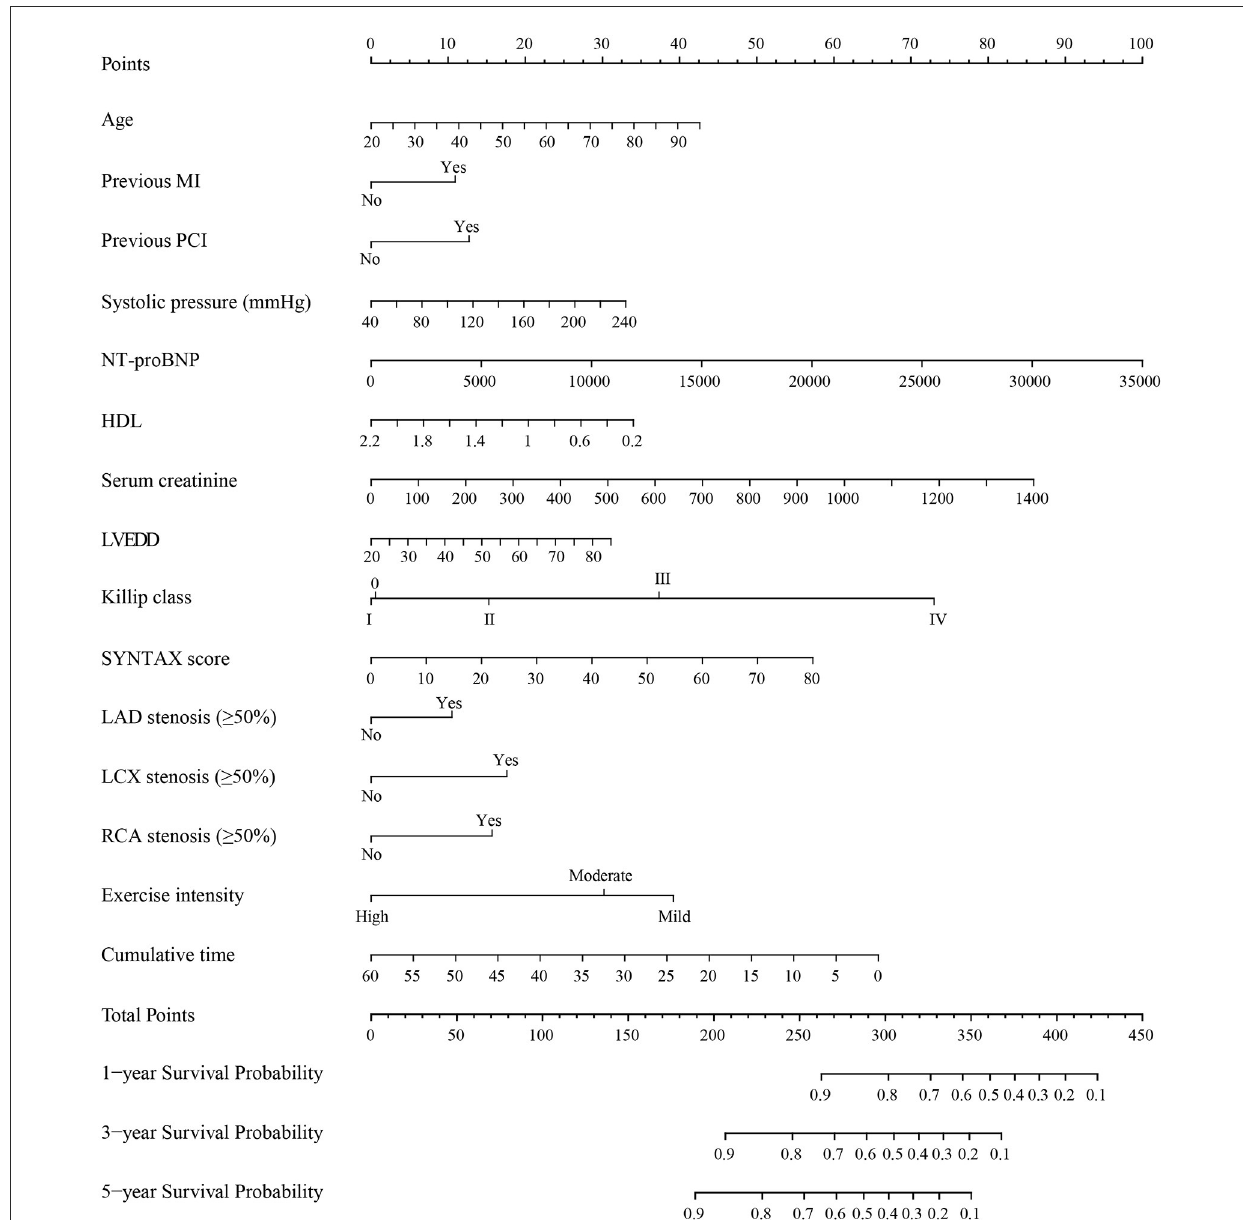
FIGURE2 Nomogram for predicting MACE in patients with ACS. MACE, major adverse cardiovascular events; ACS, acute coronary syndrome; MI, myocardial infarction; PCI, percutaneous coronary intervention; NT-proBNP, N-terminal Pro-B-type natriuretic peptide; HDL, high density lipoprotein cholesterol; LVEDD, left ventricular end-diastolic diameter; SYNTAX score, the synergy between percutaneous coronary intervention with taxus and cardiac surgery score; LAD, left anterior descending; LCX, circumflex; RCA, right coronary artery. Instructions for use of nomogram: the score of each variable was obtained by drawing a vertical line upward to the points line, then the sum of these scores was plotted on the total points line. Finally, the probability of 1-, 3-, and 5-year MACE was determined by drawing the vertical line according to the total points until it intersected with each survival